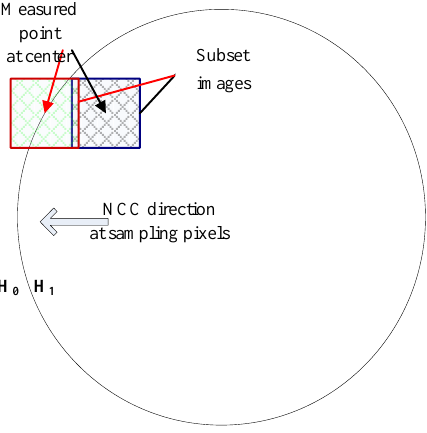
Figure 4. Measured subset image pattern formed by a surface contour edge: ( a ) measured image of multi objects; ( b ) a red square indicating measured subset image pattern along a titling contour edge, which comprises the top-left triangular region, the light diffracted region, and the bottom-right triangular region; and ( c ) two triangular subset images corresponding to their own reference heights.